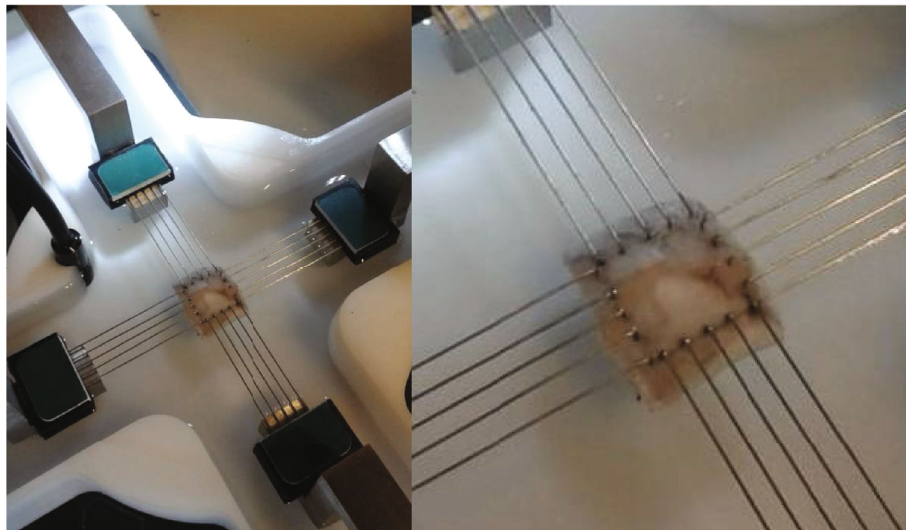
Figure 2: Experimental set-up of porcine sclera tissue subjected to biaxial tensile loading (Bio-Tester 5000 from Cellscale) (Waterloo, Canada). The hooks (BioRakes) were utilised in securing the sclera tissue and were punched thoroughly before they were inserted into the warm bath of isotonic solution 9.0g/l at pH of 5.5 at a temperature of 37 °